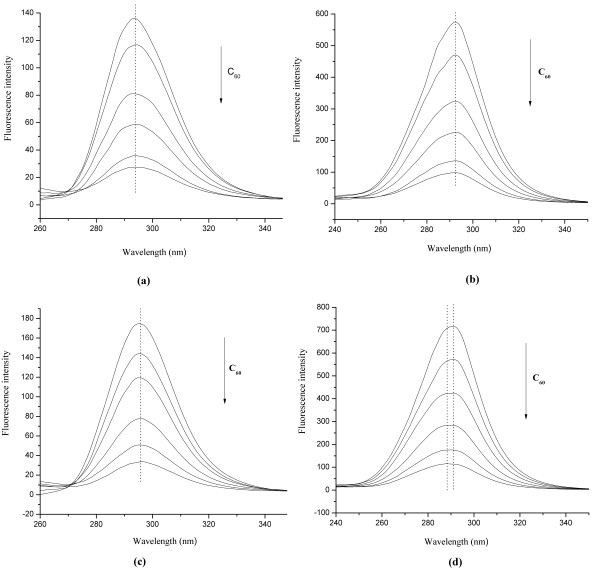
The synchronous fluorescence spectra of HSA (a, b)and BSA (c, d) in the absence and presence of C60nanoparticles. (a. HSA, Δλ = 20 nm; b. HSA, Δλ = 60 nm; c. BSA, Δλ = 20 nm; d. BSA, Δλ = 60 nm.) Conditions: HSA/BSA: 1.0 × 10-5 mol/L; C60 (from up to down): 0, 1.39, 2.78, 5.56, 8.34, 11.12 × 10-6 mol/L; pH = 7.4; ex = 292 nm.